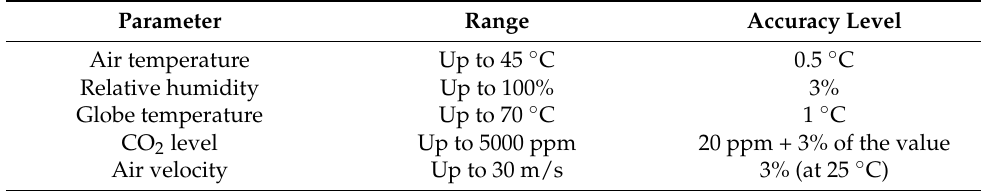
Table 1. Details of the parameters measured in the study.